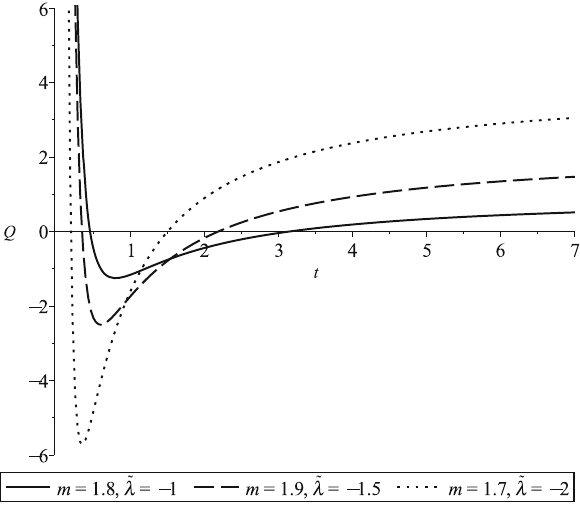
Fig. 1 The relative acceleration Q of the universe’s expansion for dif- ferent values of the parameters ˜ λ = λ × 10 − 6 and m